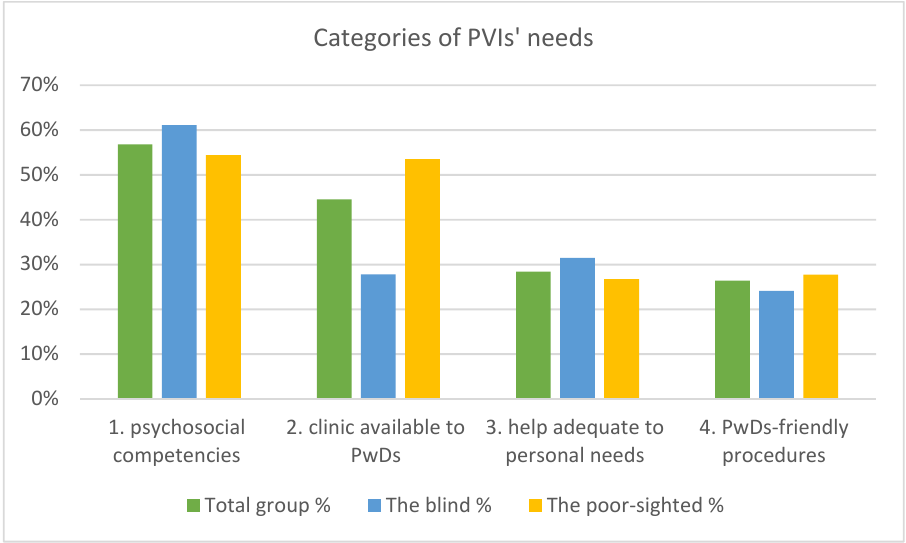
Figure 2. Categories of PVI’s needs in the total group and among the blind and poor-sighted.